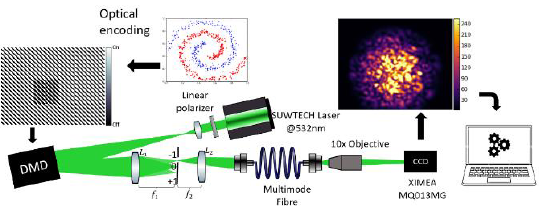
Fig. 1. Illustration of the optical set-up and methods for an optical extreme learning